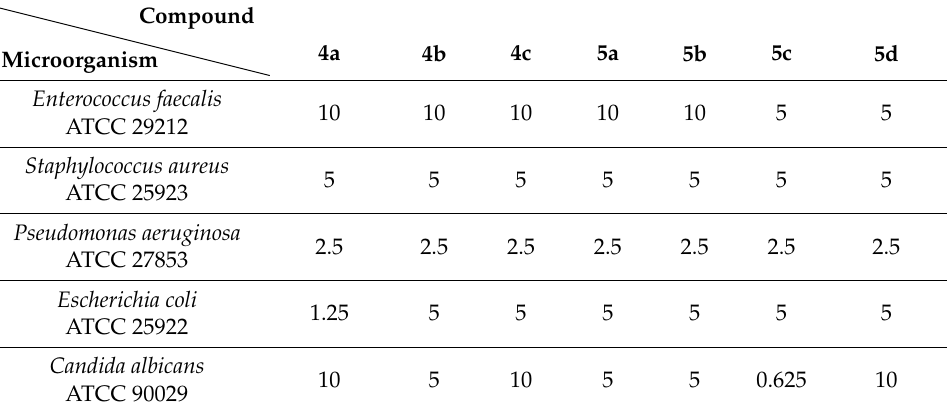
Table 2. Minimal bactericidal concentration (MBC) (mg / mL) values for the compounds 4a – c , 5a – d .